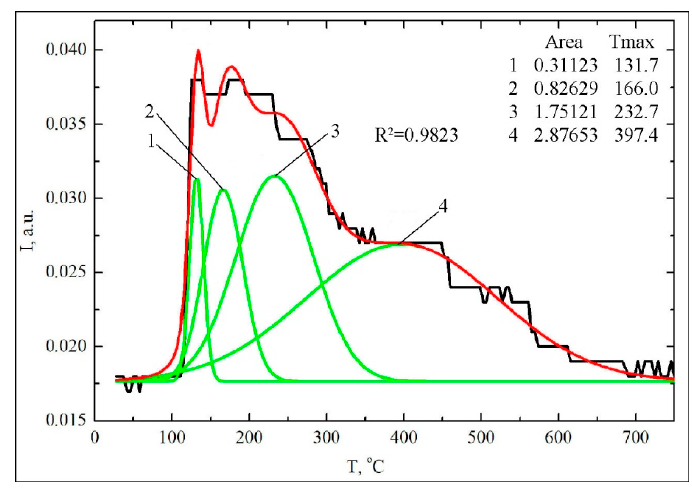
Figure 5. Deconvolution of TPD curve for ion with m / z 136. Table 3. The calculated integral intensities for the peaks of molecular ions of structurally related compounds with m / z 136 (3,4-dihydroxy-phenylethylene), 110 (pyrocatechol) and 94 (phenol). Relative content of various types of CA complexes.